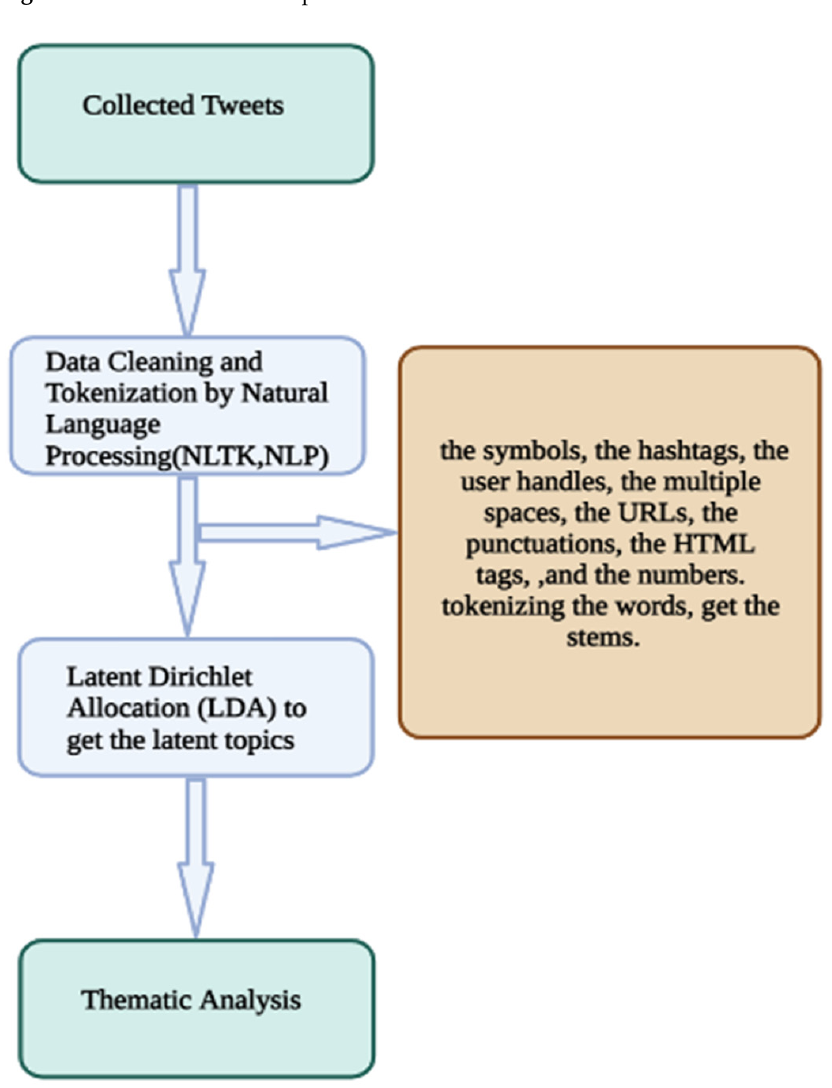
Figure 1. Process to select sample tweets.